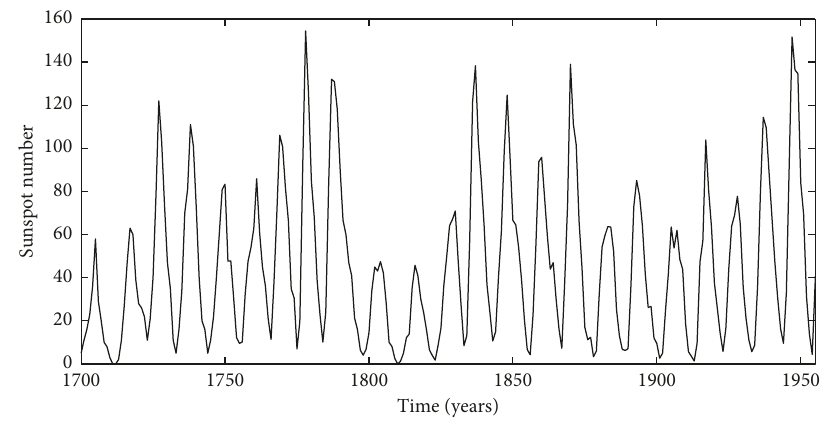
Figure 2: Sunspot